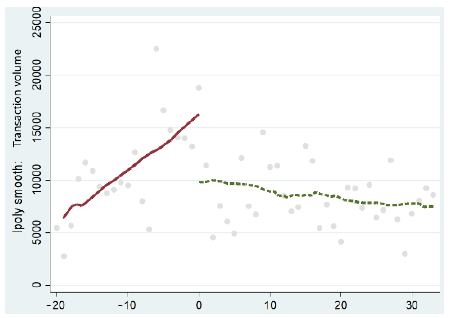
Figure 4. Impact of the resumption of home purchase restriction (HPR) on transaction volume